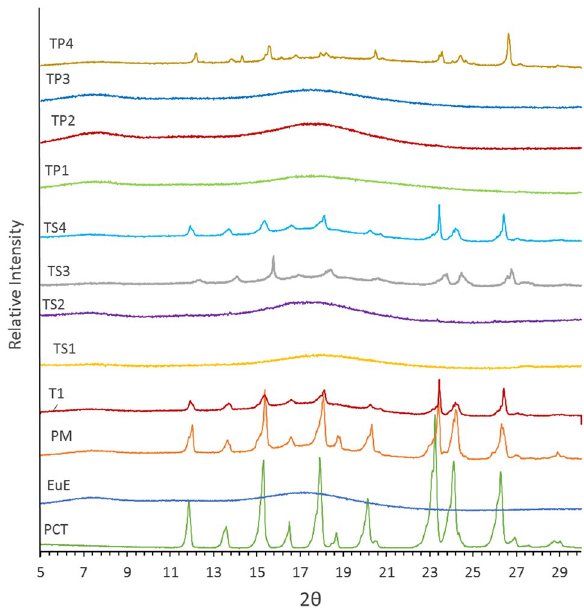
Figure 3. PXRD patterns of PCT, EuE, physical mixture, T1, TS, and TP